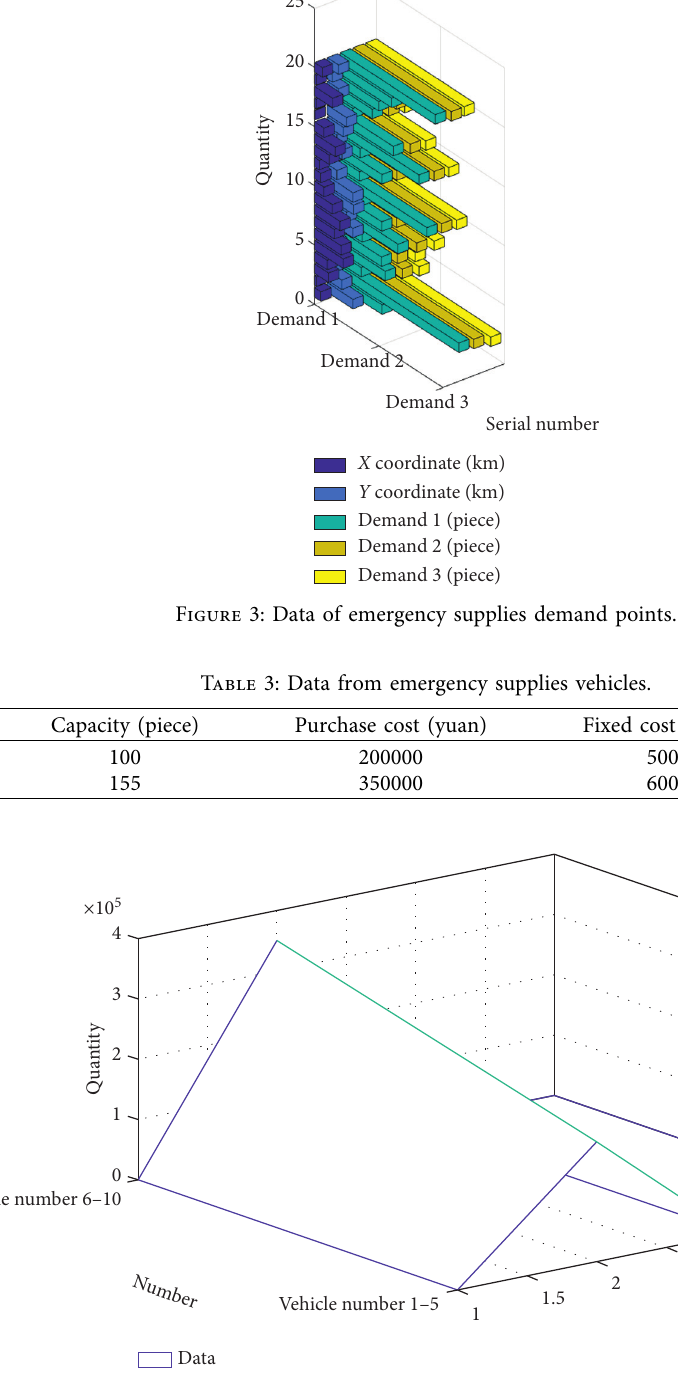
Figure 4: Data from emergency supplies